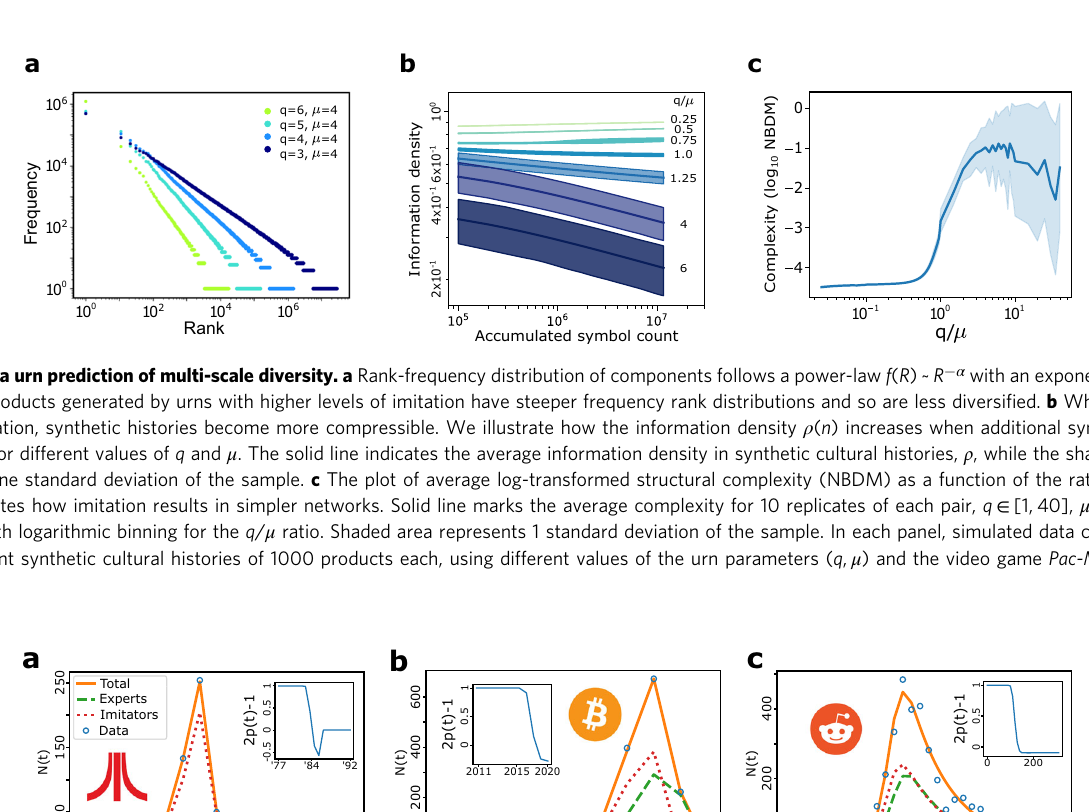
q=6, =4 q=5, =4 q=4, =4